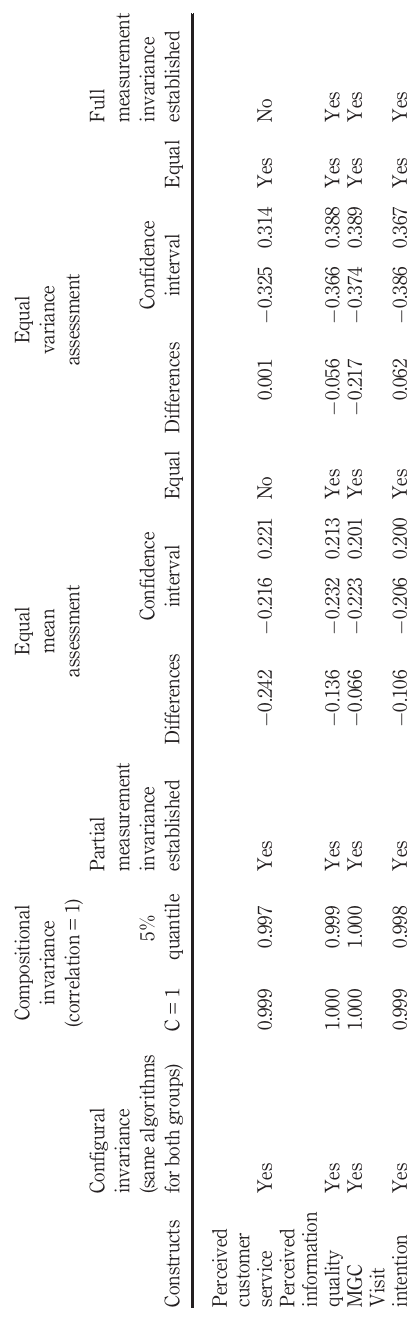
Table VI. Results of invariance measurement testing using